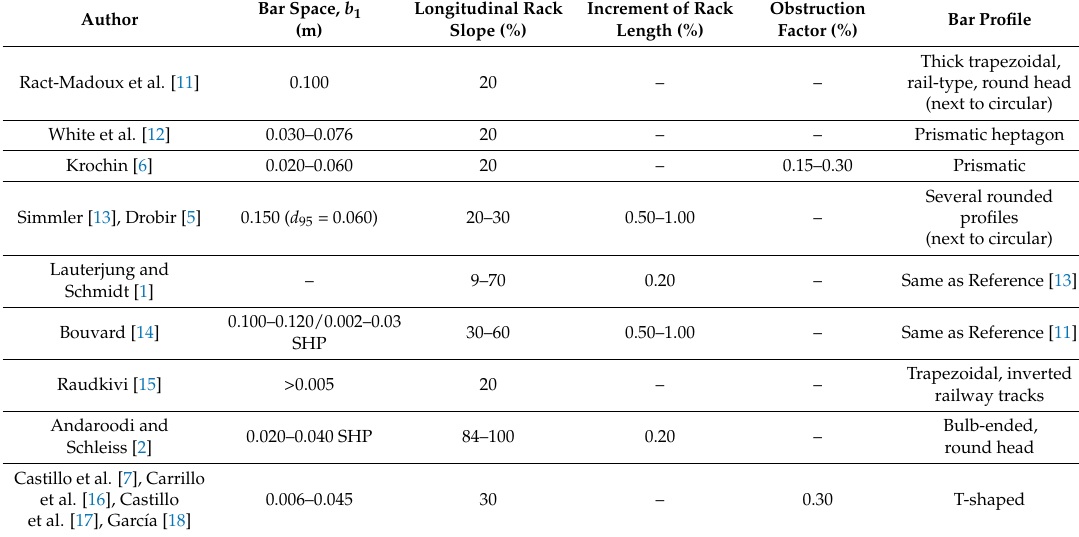
Table 1. Design parameters adopted in bottom intakes considering